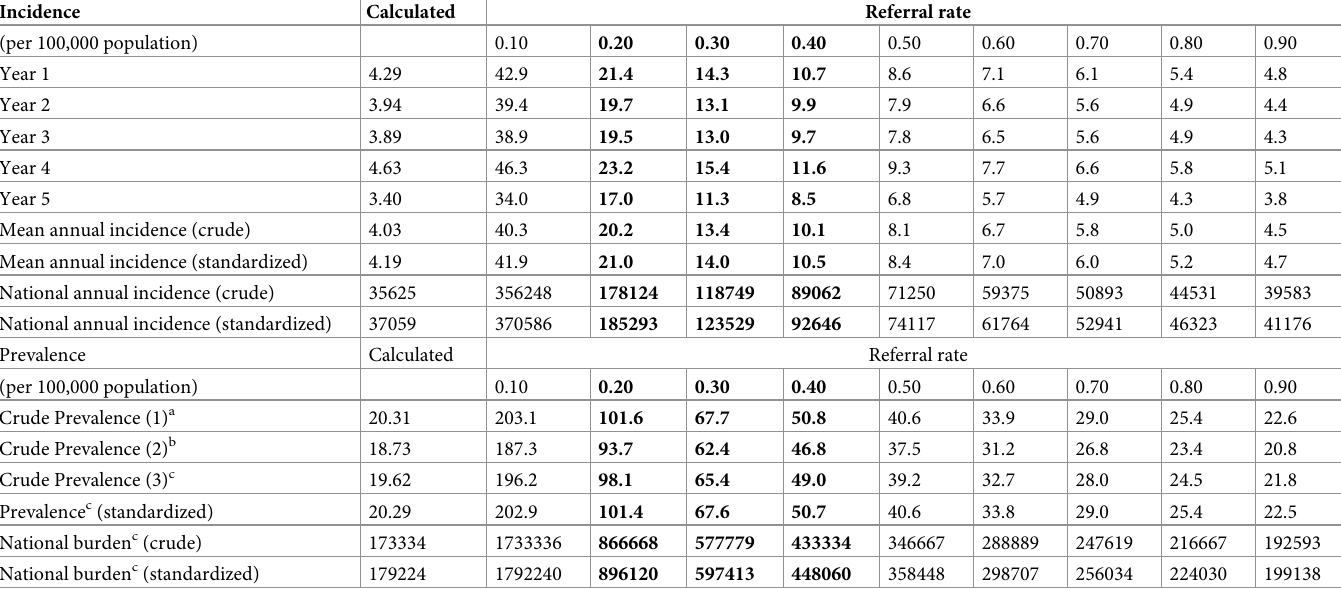
Table 5. Incidence and prevalence of interstitial lung diseases in the Tricity region and the estimated national incident and prevalent burden according to different assumptions of referral